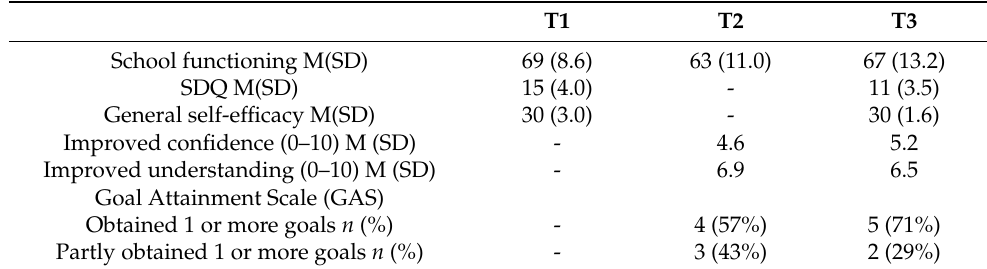
Table 3. Outcomes of the SEd intervention ( n =